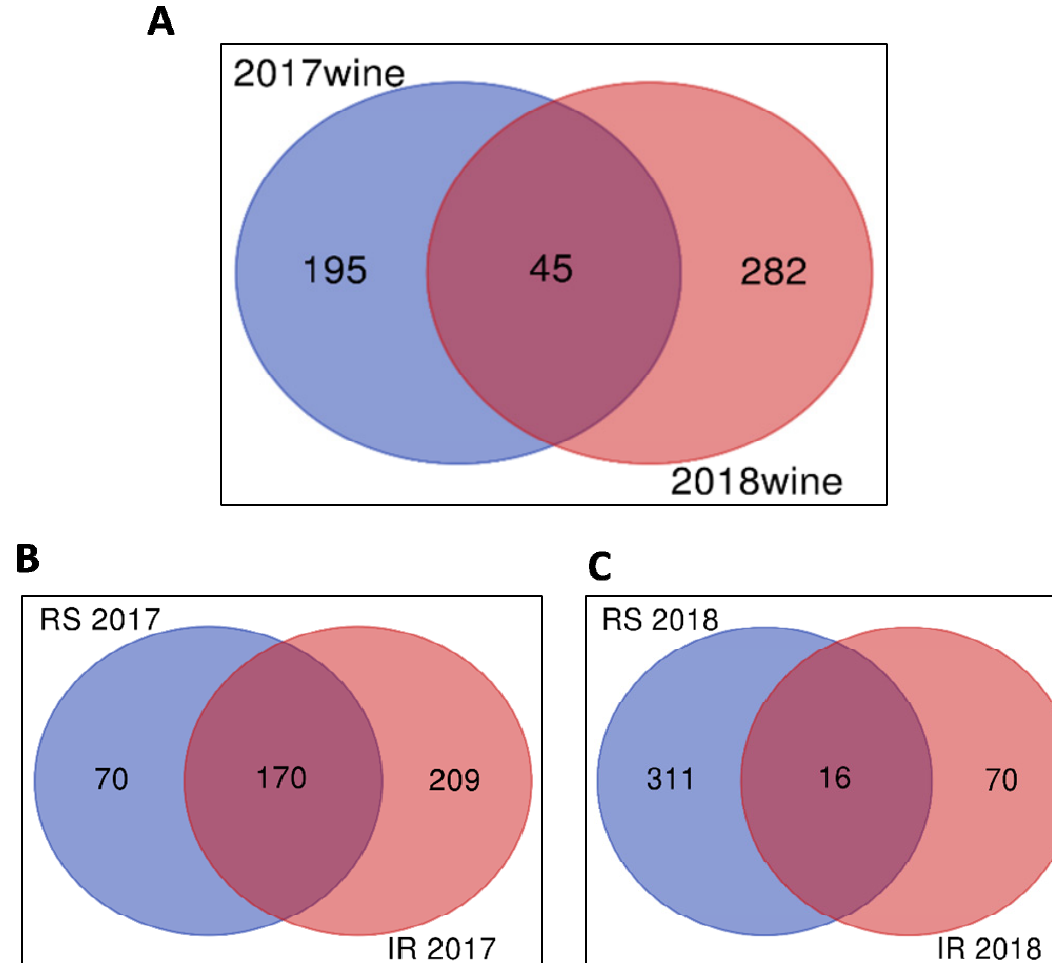
Figure 3. ( A ) Venn diagram showing common and unique features between wines in 2017 and 2018. Only 45 features were common in both years showing yearly differences in metabolites. ( B ) Venn diagram showing common and unique features between root systems and irrigation treatments in wines in 2017. 170 features were similar between root system and irrigation treatments. ( C ) Venn diagram showing common and unique features between root system and irrigation treatments in wines in 2018. Few features were similar between root system and irrigation treatments.